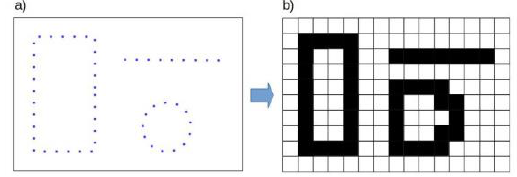
Figure 3. Rectangle, line and circunference a) after discretization and b) after occupancy map generation – empty pixels in white, and occupied pixels in black.